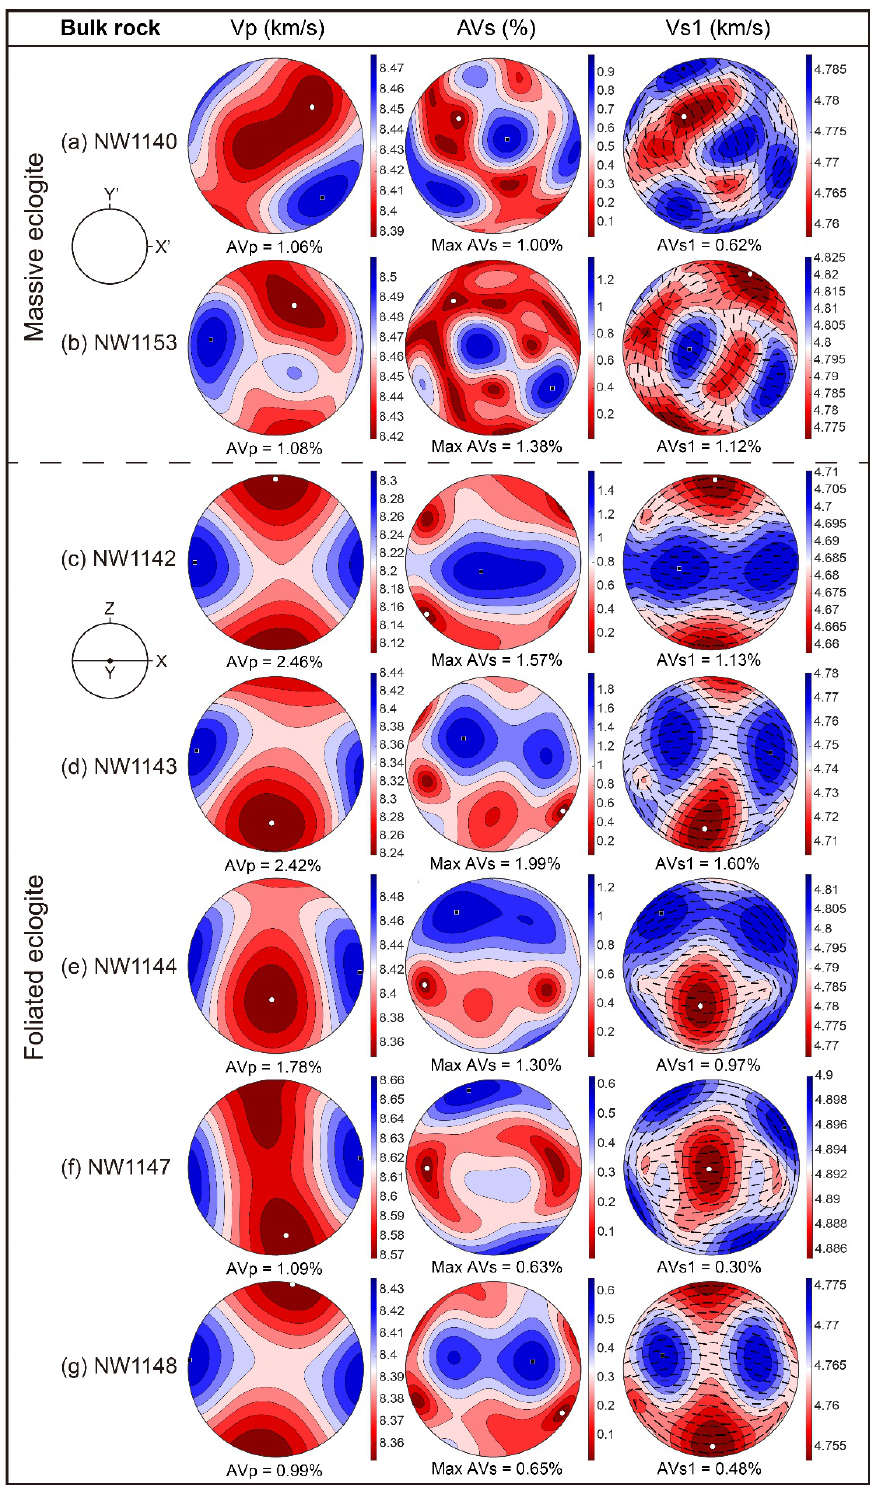
Figure 5. Bulk rock seismic properties of the MEC and FEC in ambient conditions. ( a , b ) MEC, ( c ‒ g ) FEC. Data are presented using equal area and upper hemisphere stereonets. First column: P-wave velocity (Vp) and its anisotropy (AVp); second column: shear wave splitting or S-wave polarization anisotropy (AVs) and its maximum (max. AVs); third column: fast S-wave velocity (Vs1) and its anisotropy (AVs1). The black bars in the Vs1 stereonets indicate the polarization directions of the fast shear wave. The structural references (X, Y, Z, X’, and Y’) are the same as in Figure 3.